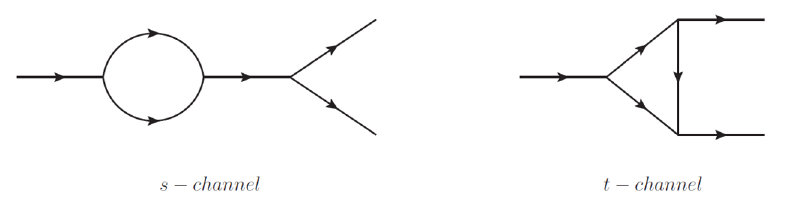
Figure 1 . s -channel (resonance) and t -channel (rescattering) contributions to final-state interac-